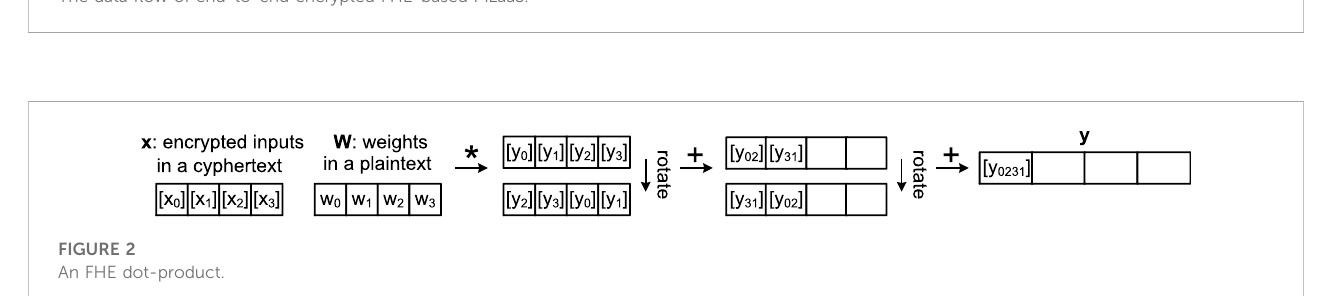
FIGURE 1 The data fl ow of end-to-end encrypted FHE-based MLaaS.